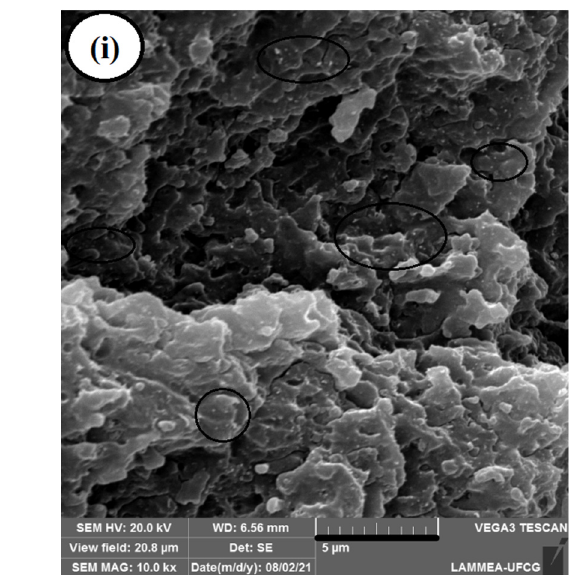
Nylon 6/ABS/ABS-g-MA